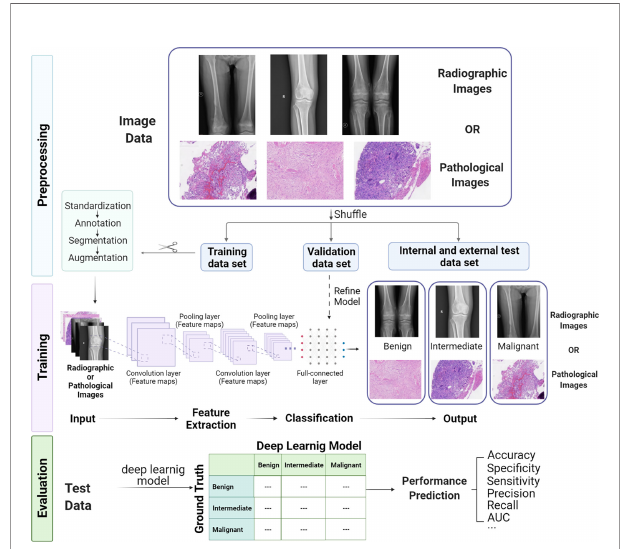
FIGURE 3 | Work fl ow of building a deep learning model for bone tumor classi fi cation based on radiological and pathological images, including preprocessing, training, and